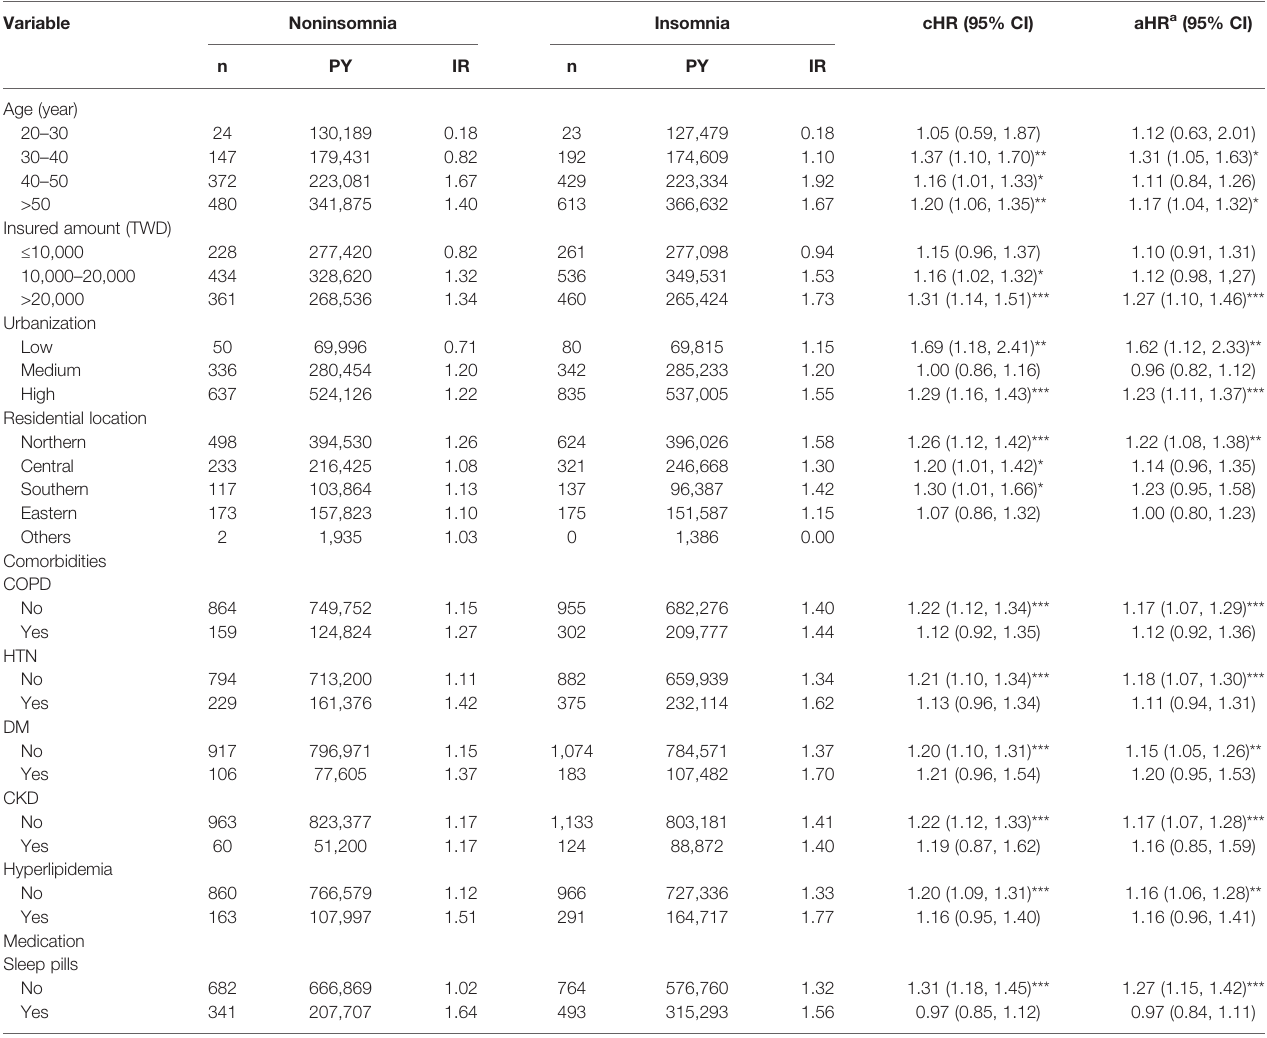
TABLE 7 | The association of insomnia and breast cancer in different strati fi cations.